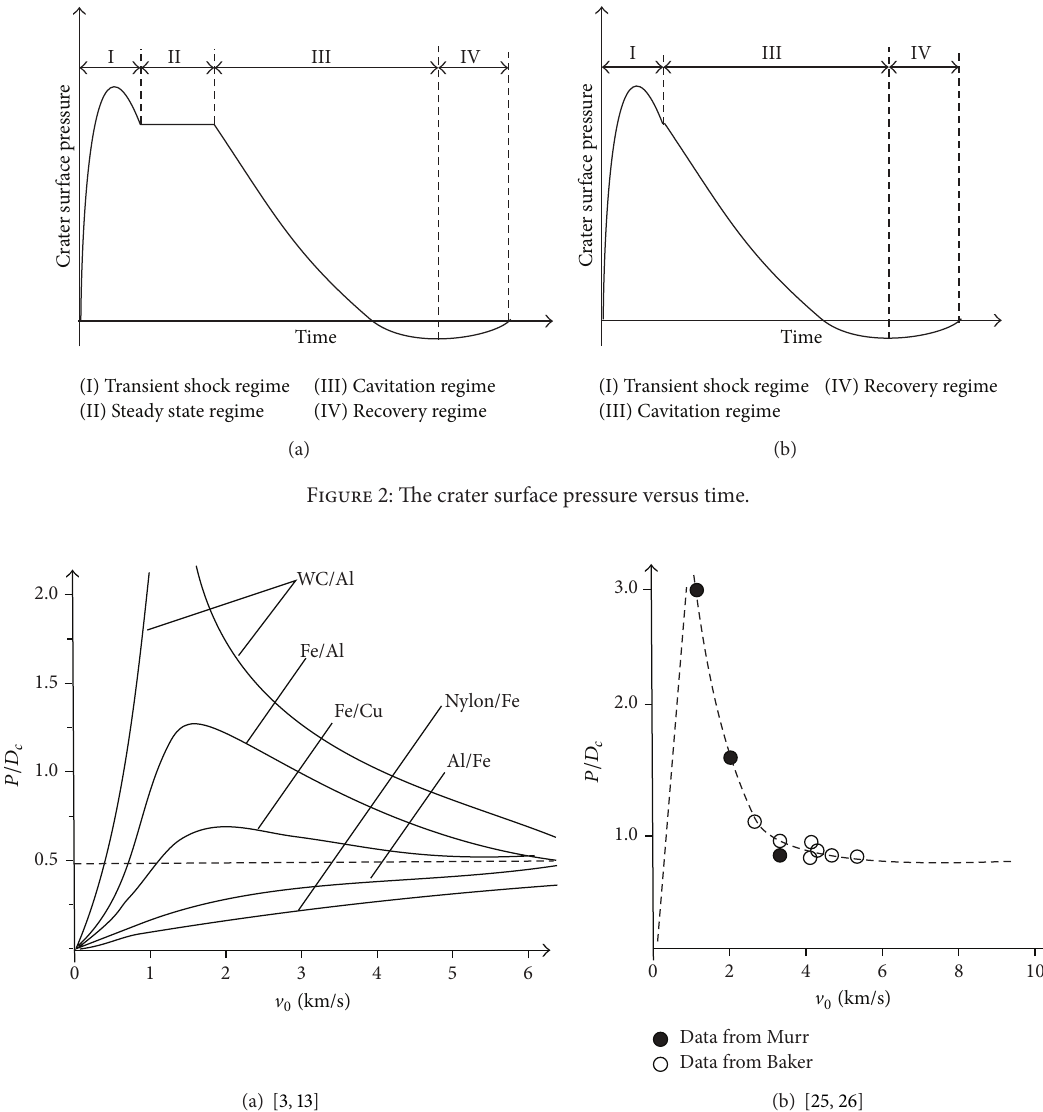
Figure 3: The relationship between crater shape and impact velocity for different projectile-target